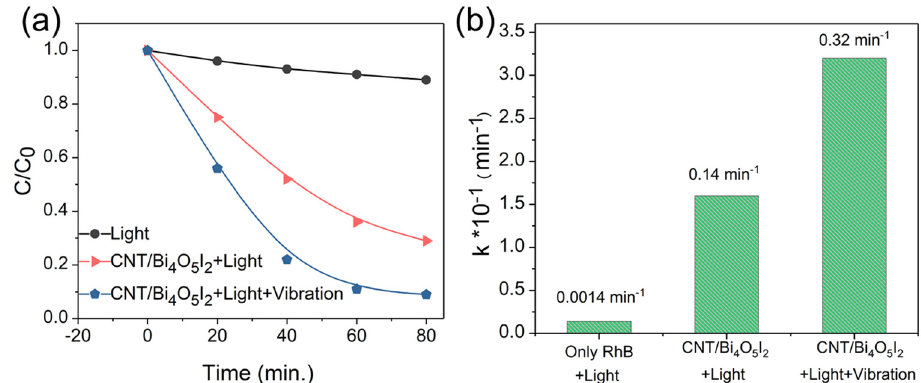
Figure 5. ( a ) Piezo-photocatalytic performances of CNT/Bi 4 O 5 I 2 composite on the degradation of RhB under different conditions; ( b ) the column chart of the corresponding k values of the CNT/Bi 4 O 5 I 2 composite.